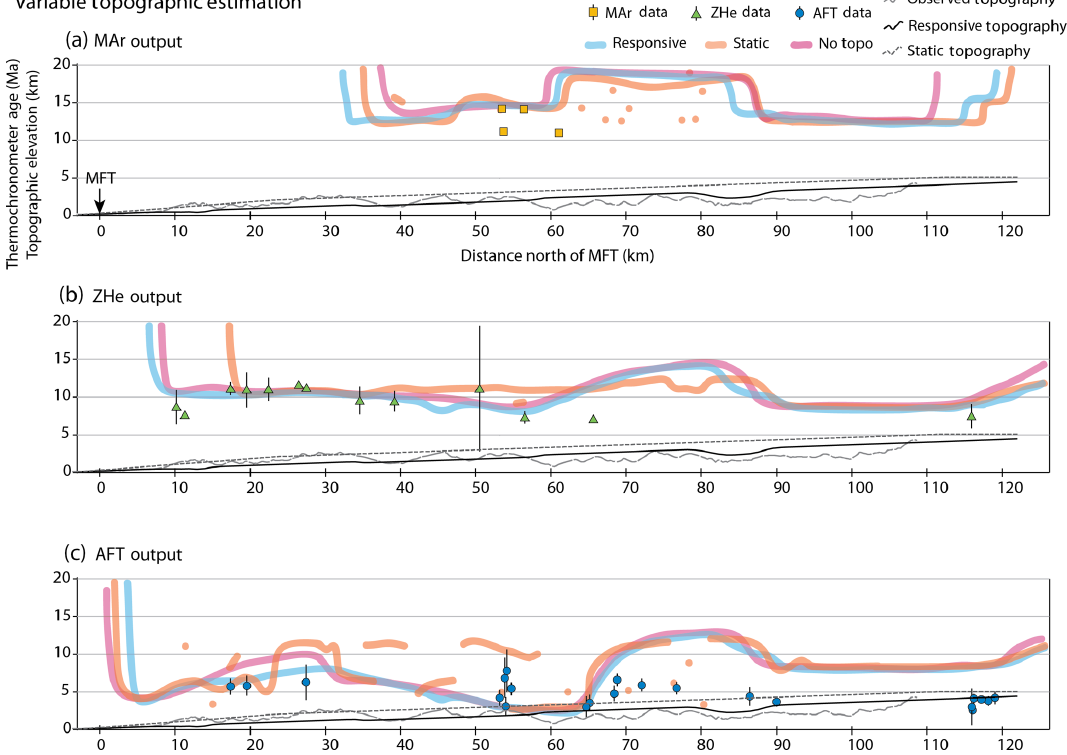
Figure 7. Predicted (a) MAr, (b) ZHe, and (c) AFT cooling ages using responsive (blue), static (orange), and no topography (red) models compared to published thermochronometer data. Other model variables are set as Split KT, velocity B, and A 0 = 2 . 5µWm − 3